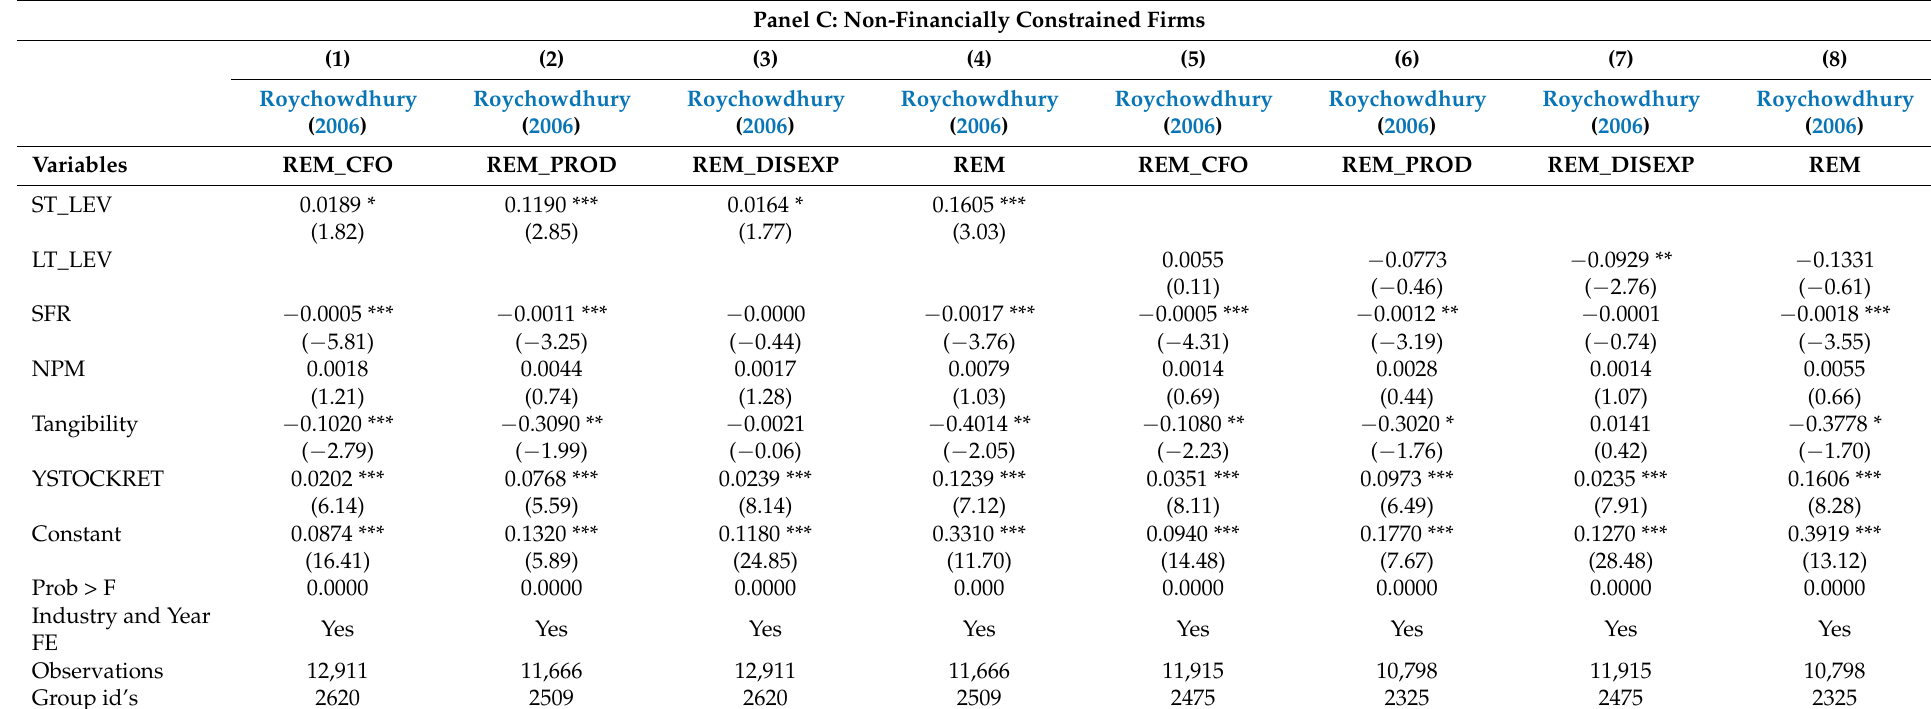
Table 7. H4 estimations (Role of short-term and long-term leverage in determining REM practices in unconstrained firms). Panel C: Non-Financially Constrained